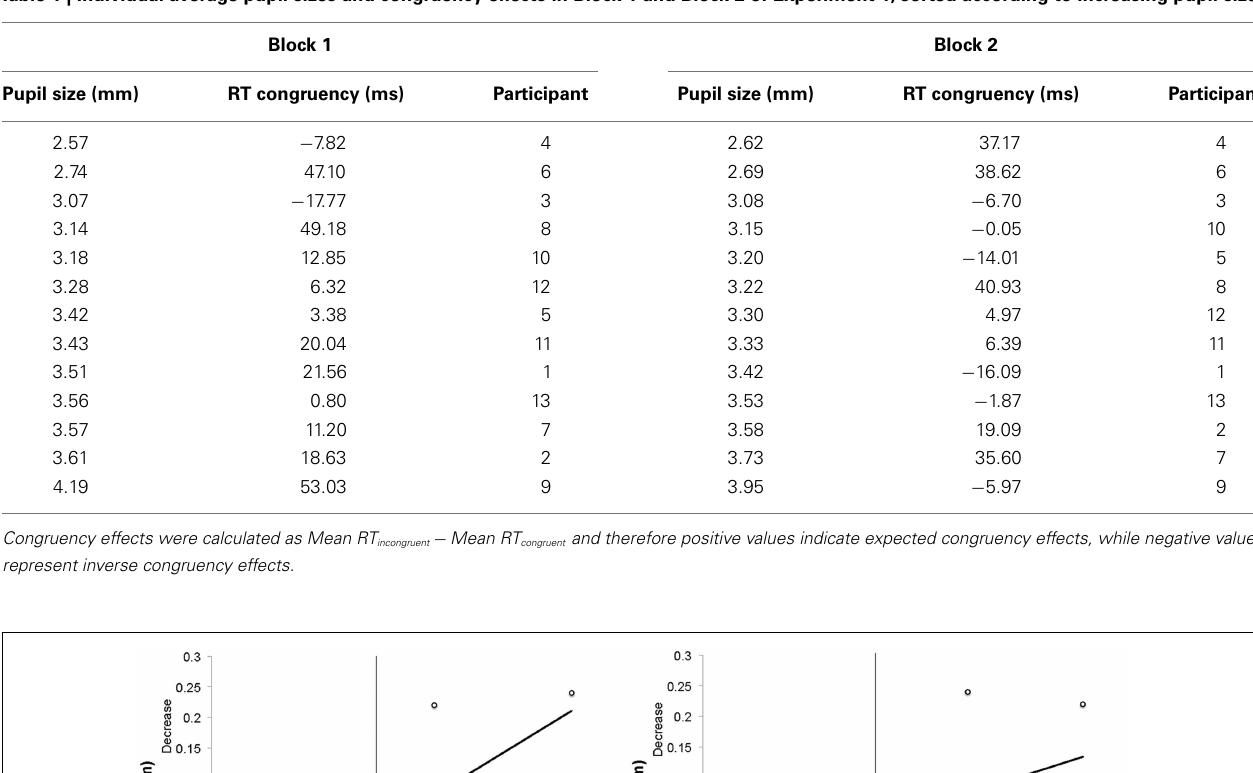
Table 1 | Individual average pupil sizes and congruency effects in Block 1 and Block 2 of Experiment 1, sorted according to increasing pupil